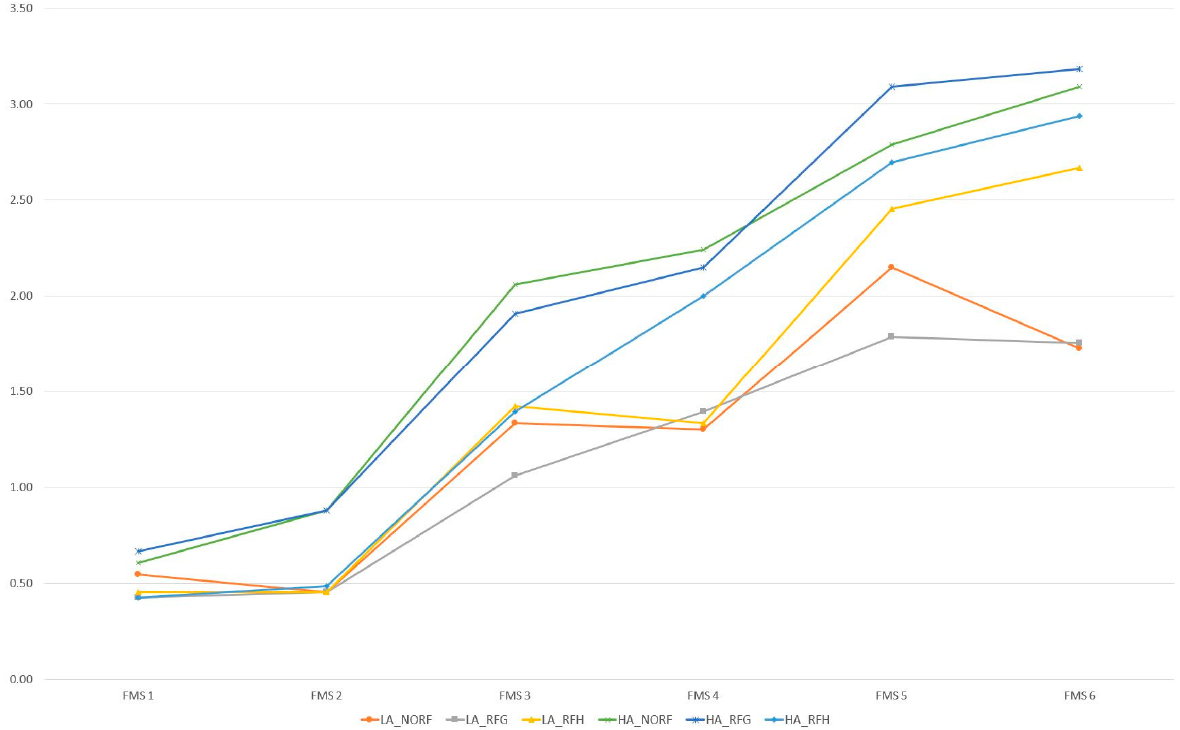
Figure 5. Progress of the average FMS scores by time and condition for all participants who completed the experiments (all six repetitions). A drop from FMS 3 to FMS 4 for the LA_NORF and LA_RFH conditions and a drop from FMS 5 to FMS 6 for the LA_NORF and LA_RFG conditions was interesting. In general, the FMS scores rose throughout the gameplay for all the conditions. The condition without the rest-frames is referred to as NORF, condition with rest-frames glasses as RFG, and condition with the baseball hat as RFH. Table 2. Subjective Virtual Reality-Induced Symptoms and Effects (VRISE) levels assessed by the Sim- ulator Sickness Questionnaire (SSQ), Fast Motion Sickness (FMS), and Virtual Reality Neuroscience Questionnaire (VRNQ) (VRISE